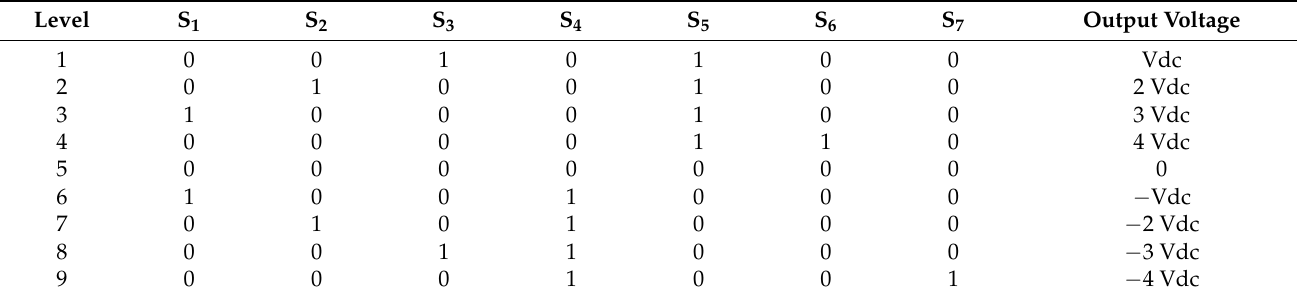
Table 1. Switching states and output voltages for the proposed inverter.